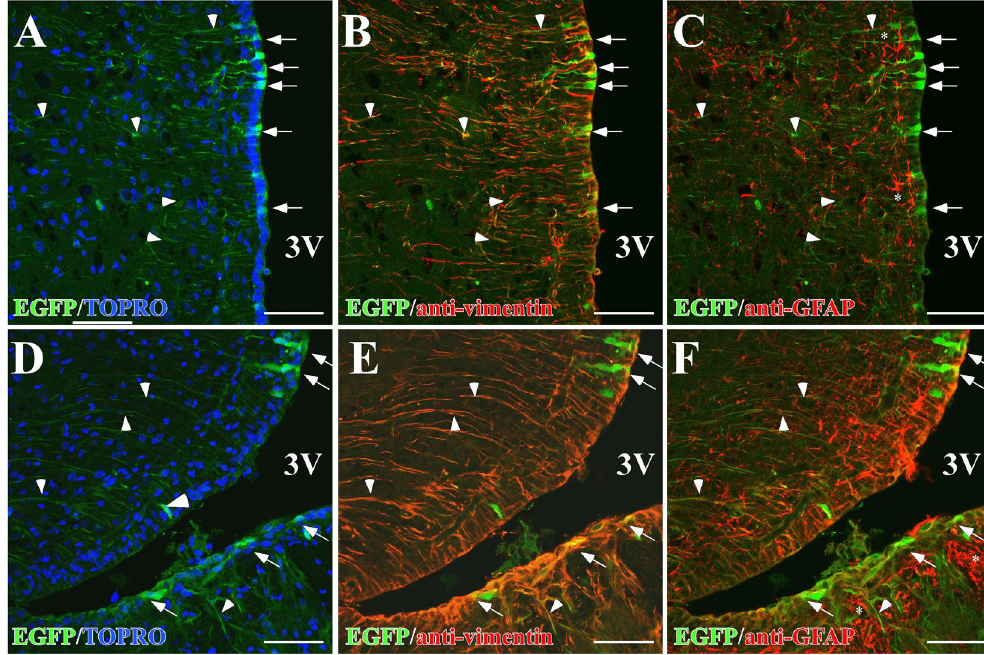
Figure 2. Distribution of EGFP in hypothalamic glial cells. ( A–F ) Representative confocal images of one focal plane using anti-vimentin (red) or anti-GFAP (red) antibodies as well as the fluorescence associated with EGFP (green) and the nuclear marker, TOPRO-3 (blue). ( A–C ) Adenoviral transduction in α -tanycytes. ( D–F ) Adenoviral transduction of β -tanycytes. ( A , C ) EGFP detected in apical membranes (arrows) and in long cellular processes in the basal hypothalamus (arrowheads). ( B , E ) Vimentin showing both proximal (arrows) and distal (arrowheads) tanycyte regions and colocalization with the EGFP. ( C , F ) GFAP showing astrocyte distribution, the absence of GFAP in the ventricular wall (arrows) and EGFP-positive processes (arrowheads). Scale bars ( A–H ) 50 µ